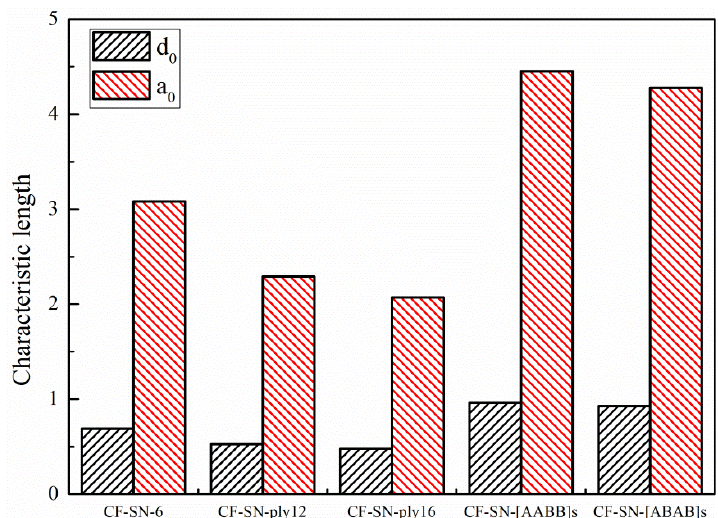
Figure 27. Comparison of characteristic lengths calculated by the standard specimen of each type of specimen (equal specimen size group/equal ratio of 𝑊 /2 𝐶 group/CF-SN-ABAB/CF-SN-AABB/CF-SN-ply12/CF-SN-ply16); the characteristic length is different when the class of specimen (lay-up sequence, and same lay-up thickness) is different.